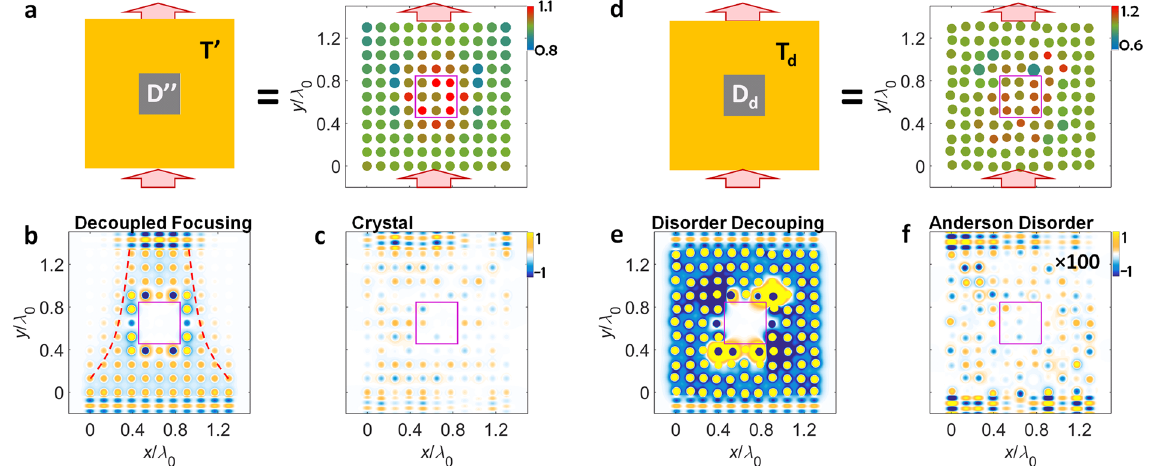
Figure 3. Demonstration of eigenstate decoupling with functionalities of focusing and disorder-resistant transport. ( a–c ) The decoupling with wave focusing (T’): ( a ) a schematic, ( b ) the field profile in the eigenstate decoupling system, and ( c ) the field profile in the ordinary crystal system. ( d–f ) The decoupling in the disordered system (D d , T d ): ( d ) a schematic, ( e ) the field profile in the eigenstate decoupling system, and ( f ) the field profile in ordinary Anderson off-diagonal disorder system. The position of each resonator in ( d–f ) is randomly deformed for x and y axes, with the ± Λ 0 /10 maximum deformation for the original periodicity Λ 0 . The field amplitude in ( f ) is magnified ( × 100) for the presentation. All other parameters are the same as those in Fig.